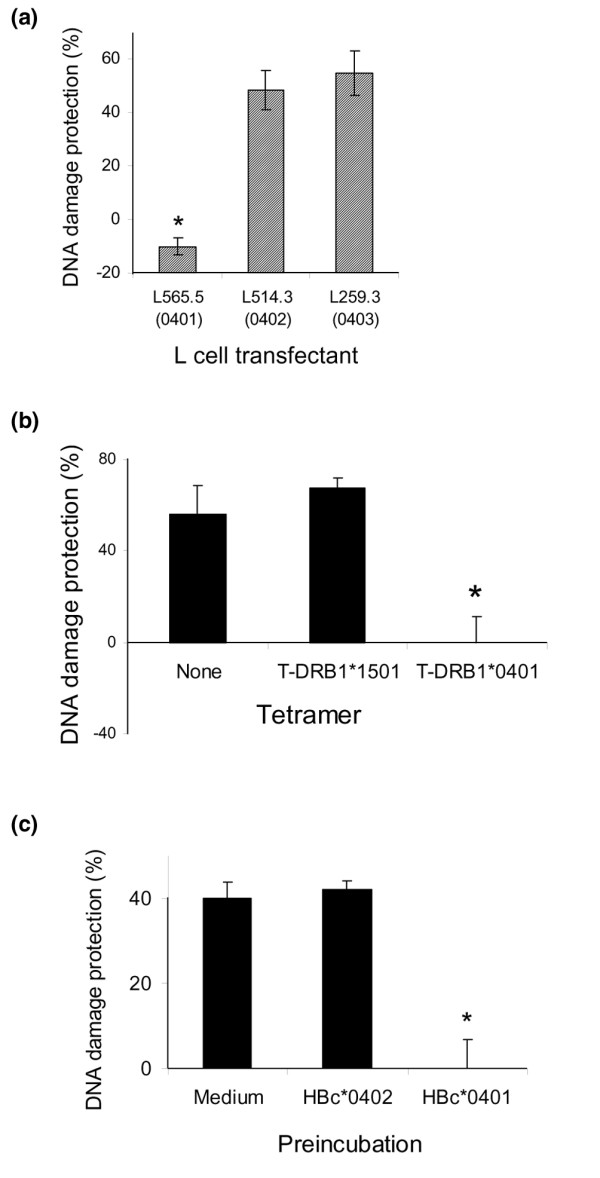
The shared epitope (SE) attenuates adenosine-induced protection against oxidative DNA damage. (a) The potency of adenosine-mediated anti-oxidative signaling was determined in L-cell transfectants expressing cDNA corresponding to DRB1*0401 (L565.5), DRB1*0402 (L514.3), or DRB1*0403 (L259.3). (b) Human M1 fibroblasts were incubated for 1 hour with or without 24 μg/ml of SE-positive (T-DRB1*0401) or SE-negative (T-DRB1*0401) tetrameric molecules. At the end of incubation, the extent of adenosine-induced protection against oxidative DNA damage was determined as above. (c) M1 human fibroblasts were pre-incubated overnight in the absence or presence of 2.5 μg/ml of either HBc*0401 or HBc*0402 multimeric proteins. At the end of incubation, the extent of adenosine-induced protection against oxidative DNA damage was determined. *p < 0.05.